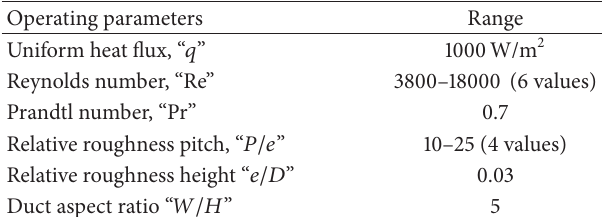
Table 2: Range of operating parameters for both geometries used in artificially roughened solar air heater